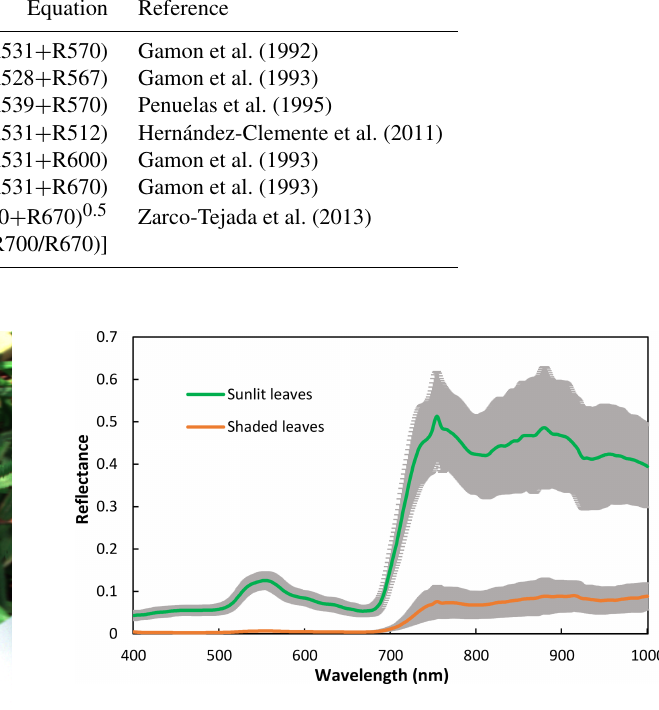
Figure 2. Spectra of sunlit and shaded leaves. The solid lines are the mean reflectance of the samples and the shadings are the standard